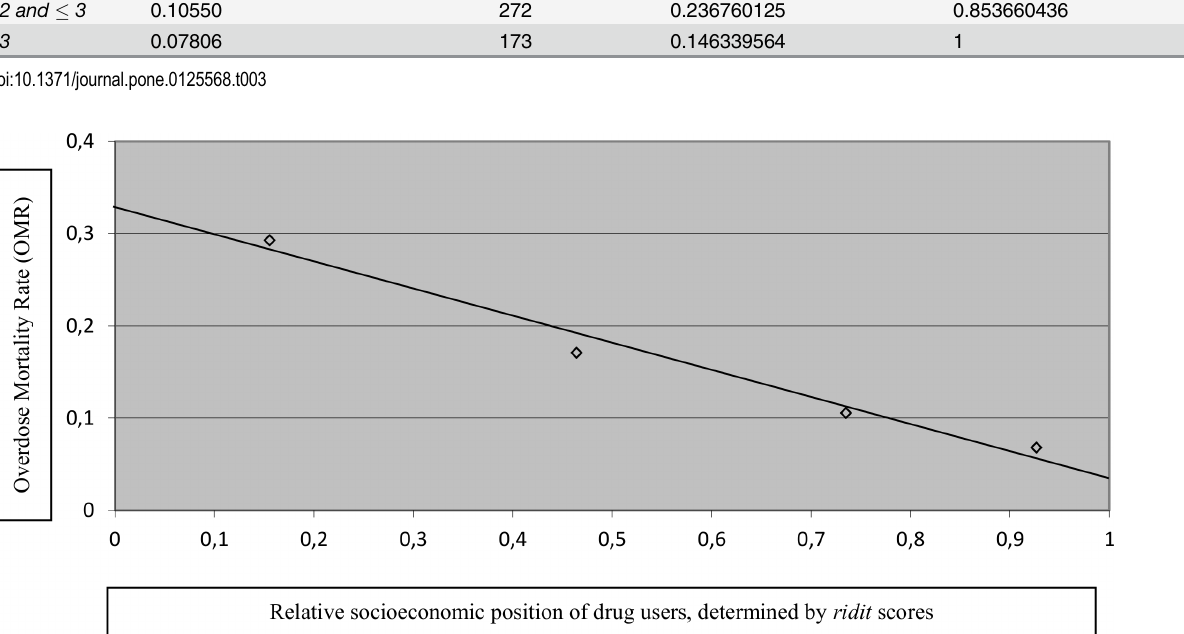
Fig 1. Overdose Mortality Rate (OMR) according to relative socioeconomic position determined by ridit scores associated to SIAS . Fig 1 shows that the overdose mortality rates decrease with increasing relative socioeconomic positions of opioids ’ and/or cocaine users.